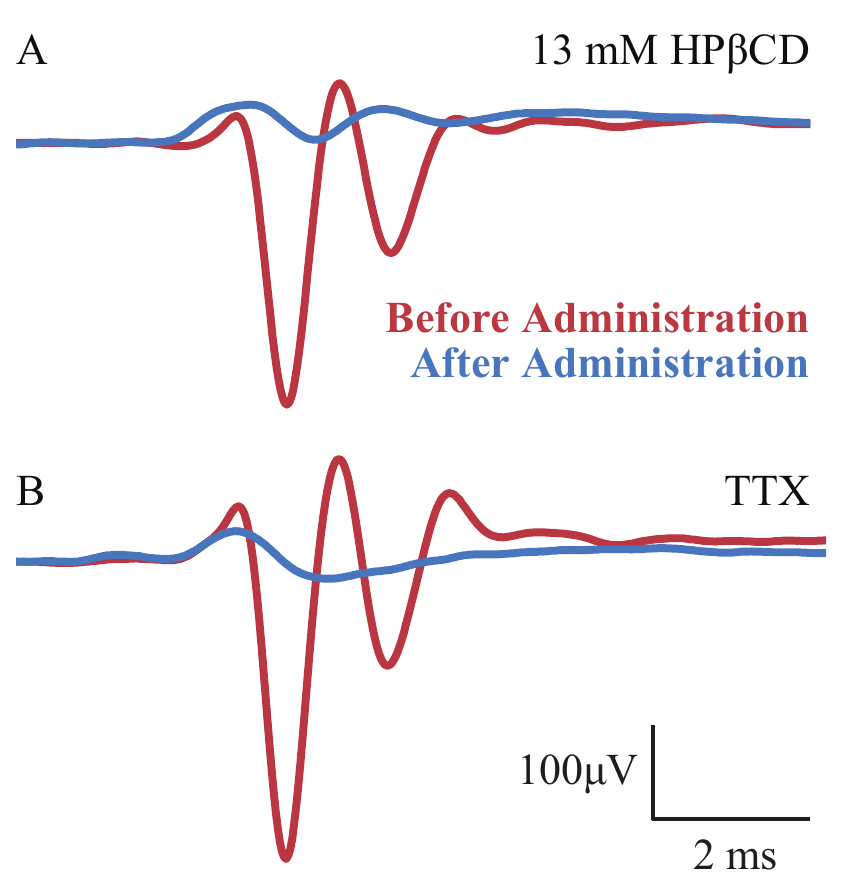
Fig 11. Cochlearresponsemeasurements from two different animalsmade before (red) and after (blue) treatment with HP β CD(Panel A) and TTX (Panel B) to 80 dB SPL 4 kHz tone bursts. Cochlear response waveformmaintainedCAP-like morphologyafter HP β CDtreatment, consistent with reducedmechanical drive to neural excitation(Panel B, blue). In contrast, response waveformis EPSP-like followingTTX treatment. Unlike TTX, results from HP β CDdo not support the hypothesisthat the auditory nerve is a site of action for 13 mM HP β CD.